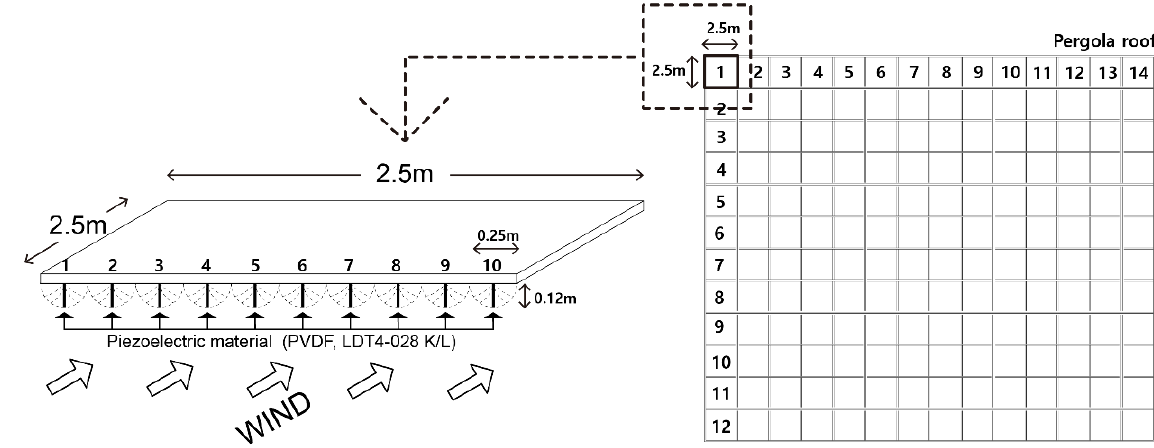
Table 5. Energy generation of a prototype (volume = 0.144 cm −3 ) of PVDF (LDT4-028 K/L), which is (L) 60 mm × (W) 120 mm × (t) 0.2 mm, according to the monthly wind speed.